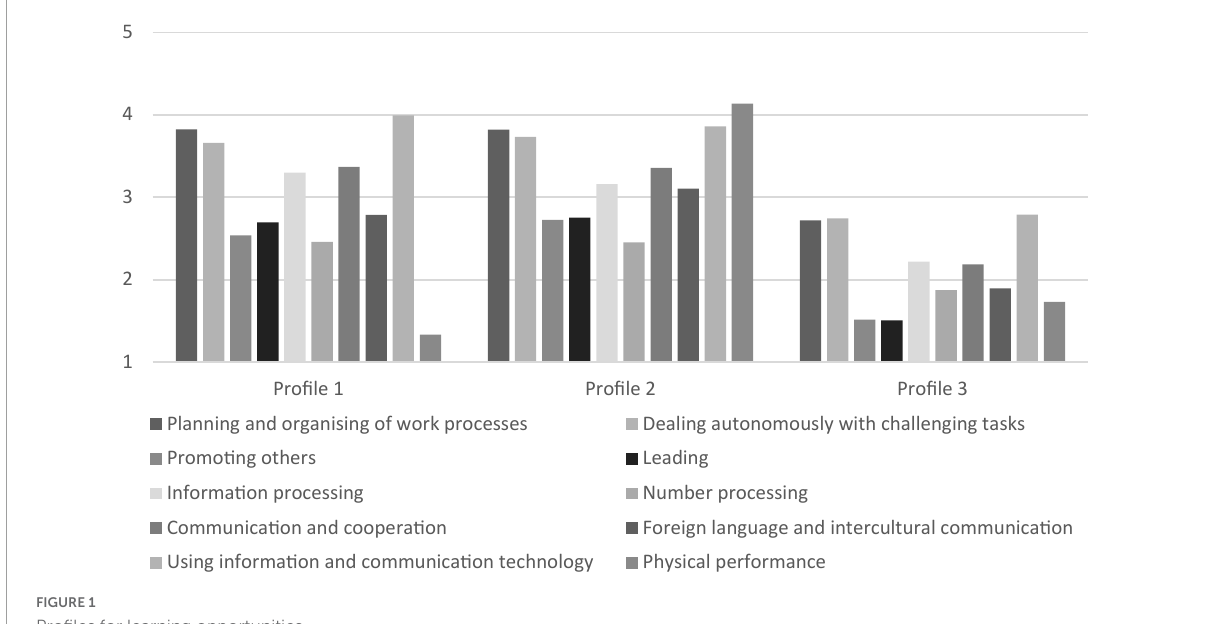
FIGURE1 Profiles for learning